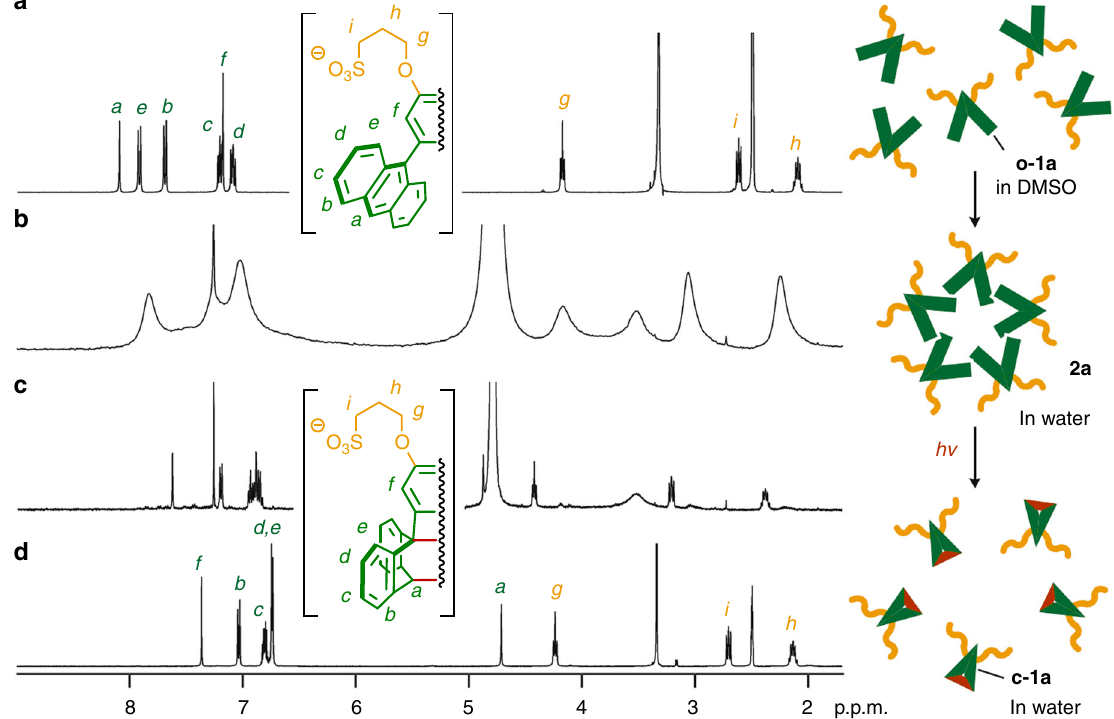
Fig. 2 Assembly and light-induced disassembly of the nanocapsule in water. 1 H NMR spectra (400 MHz, room temperature; left) and schematic representation (right) of a V-shaped amphiphile o-1a in DMSO- d 6 , nanocapsule 2a (1.0 mM based on o-1a ) in D 2 O (with tetramethylsilane in CDCl 3 inlet) b before and c after light irradiation (380 nm) for 10 min and d the photoproduct (closed amphiphile c-1a ) in DMSO- d 6